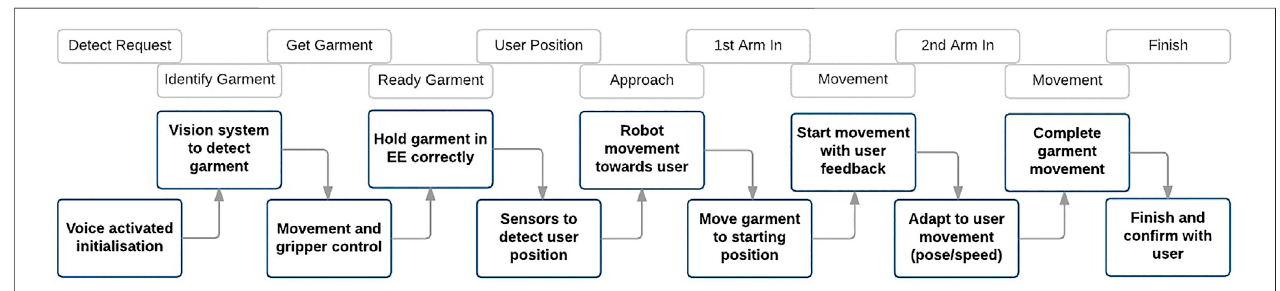
FIGURE 2 | Jacket or gown dressing scenario.